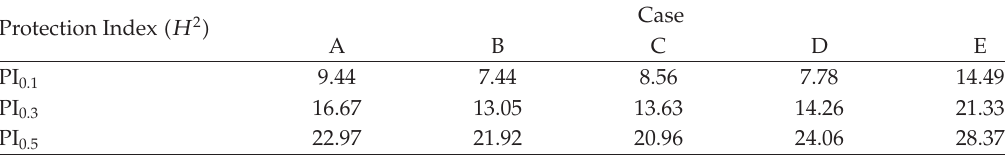
Table 1: Areas under contours U/U 0 (cid:3) 0 . 1 , 0 . 3 and 0 . 5 behind the